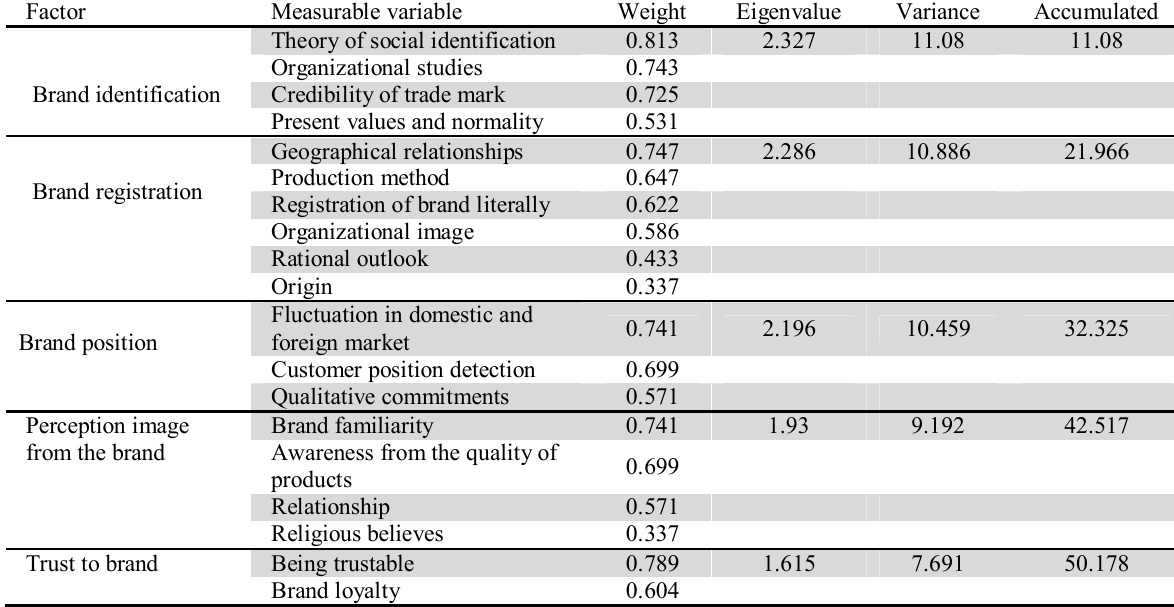
The summary of factor analysis